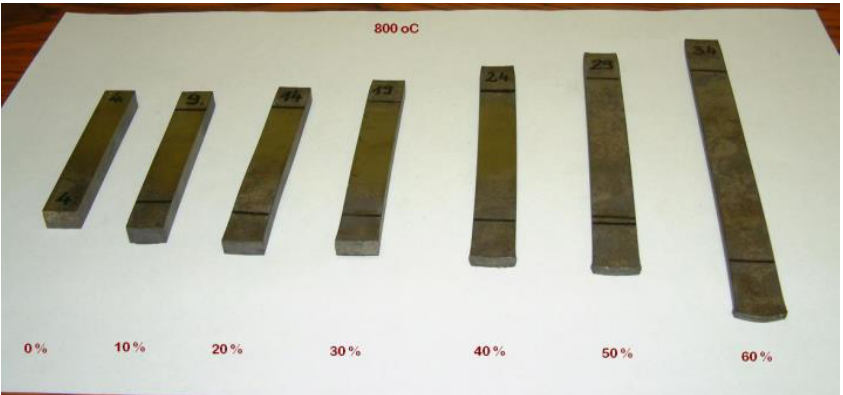
Figure 1. A specimen set. It contains an initial sample and six differently cold-rolled samples. All of them were heat-treated at 800 °C for 30 min.